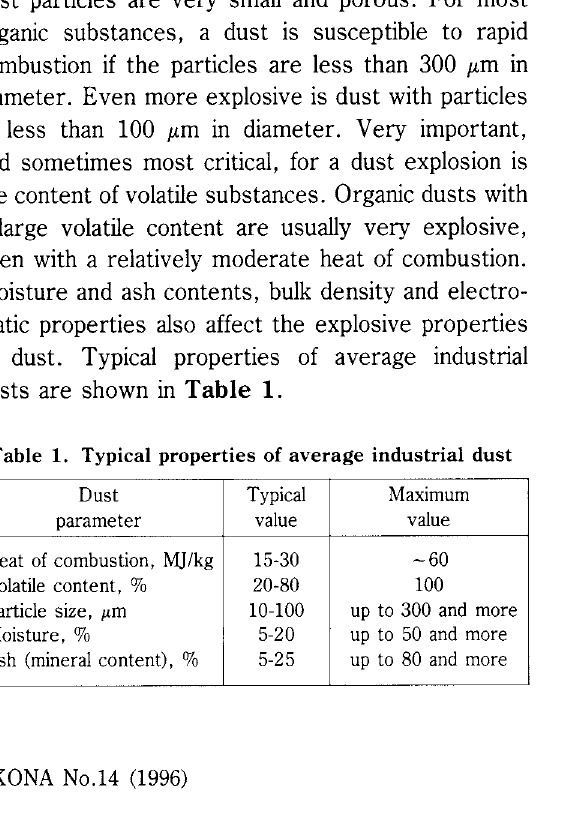
Fig. 1. Major factors influencing dust explosion.